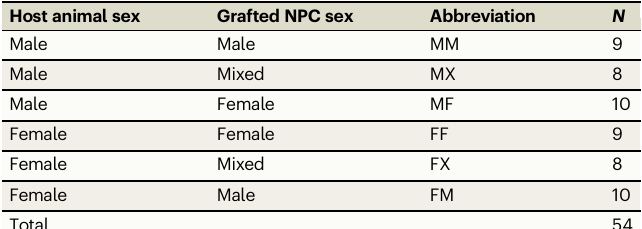
Table 3 | Experimental groups in this